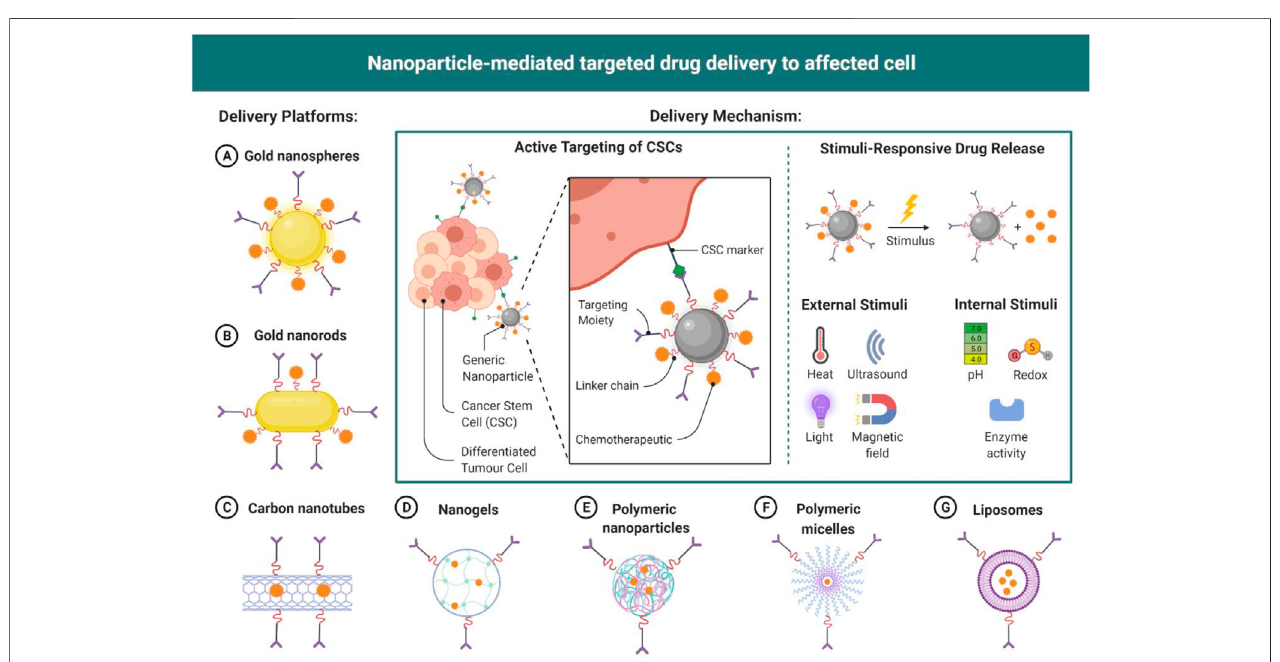
FIGURE 3 | Different nanomaterial and nanomaterial mediated drug delivery to affected cells.